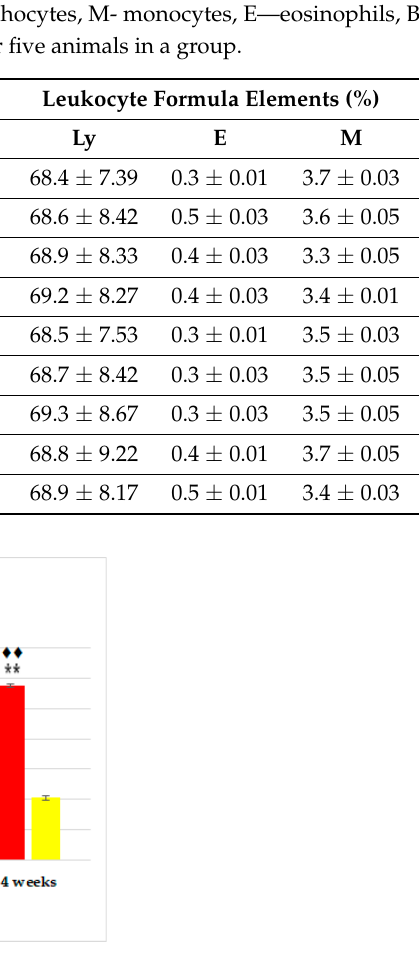
8 of 19 Table 2. The effect of Zn on percentages of the leukocyte formula elements in diabetic rats. (PMN— polymorphonuclear neutrophils, Ly—lymphocytes, M- monocytes, E—eosinophils, B—basophils ).